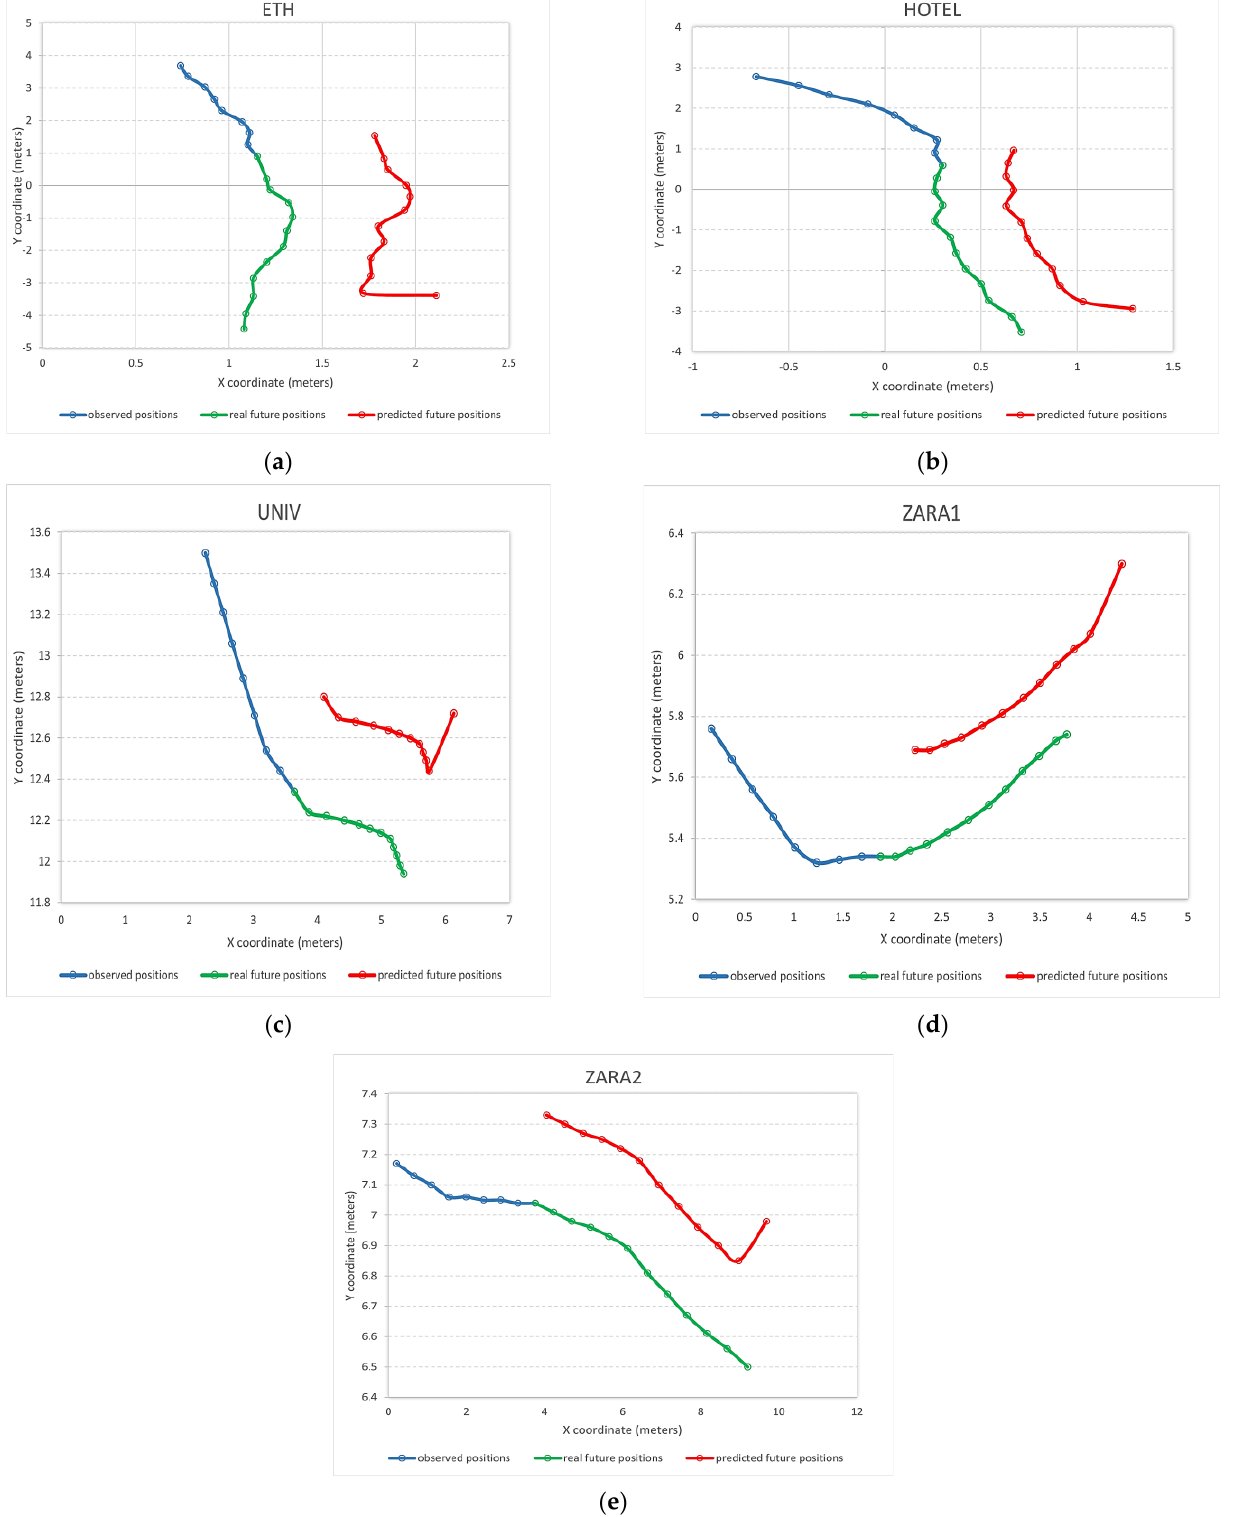
Figure 4. Examples of trajectory prediction results. ( a ) Pedestrian crossing the road in the ETH scene. ( b ) Interaction of pedestrians and objects in the HOTEL scene. ( c ) No social interaction in the UNIV scene. ( d ) Sudden change in direction in the ZARA1 scene. ( e ) Pedestrians walking together throughout the ZARA2 scene.